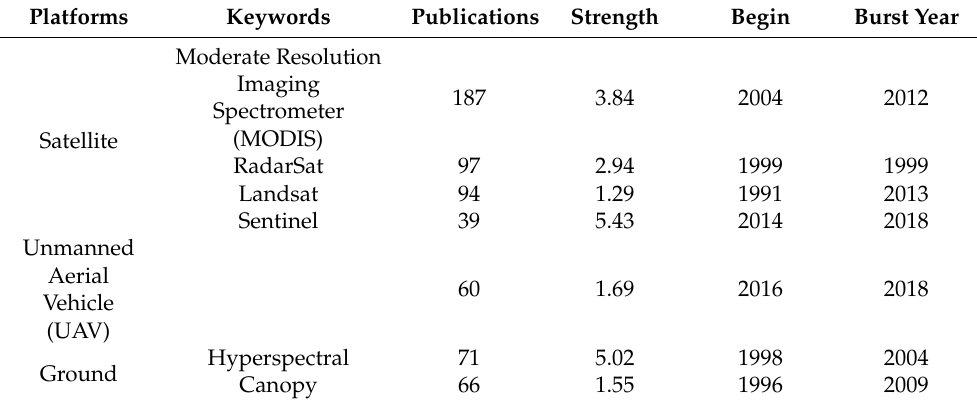
Table 8. Analysis of the hot spots of rice research from the perspective of sensor platforms.